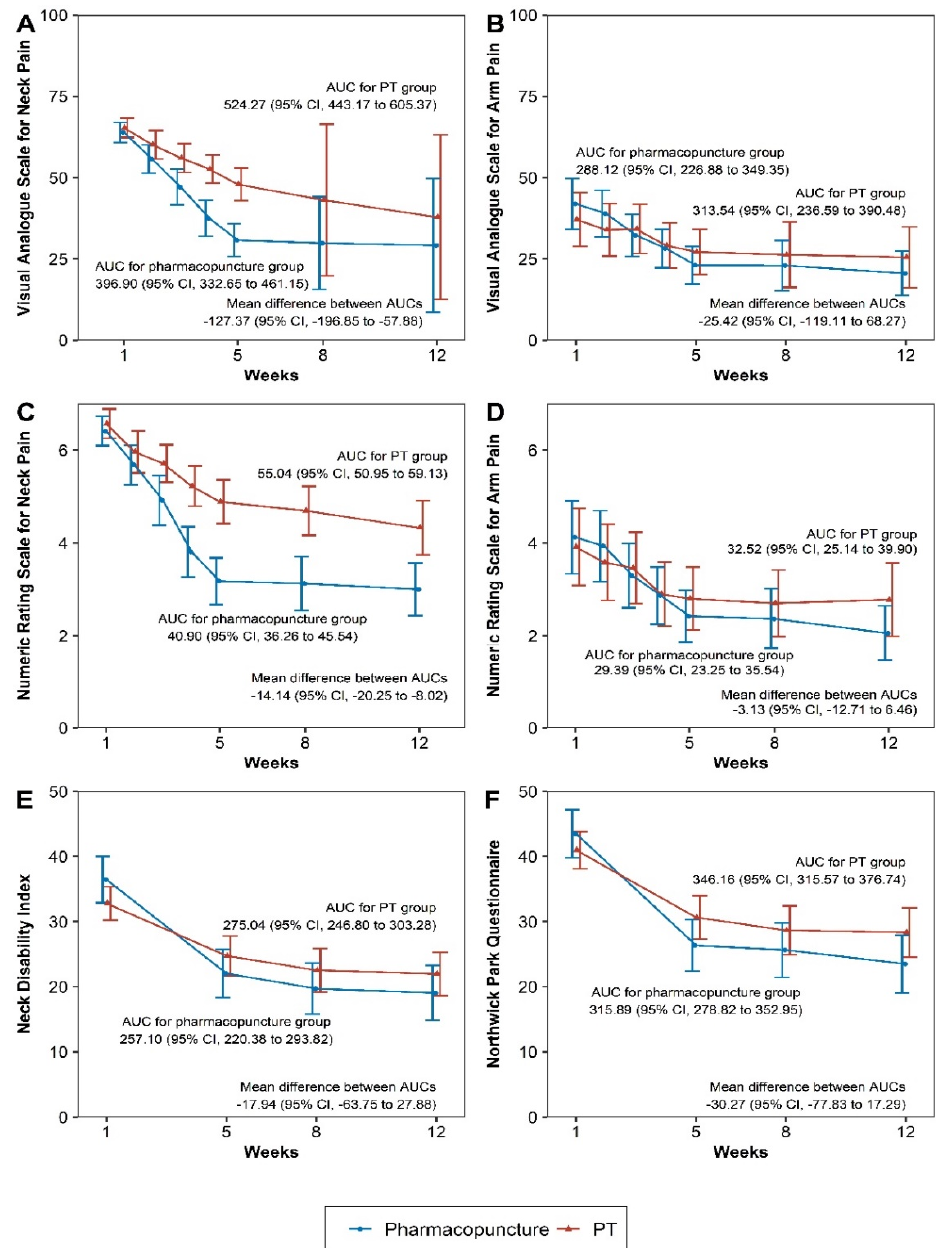
Figure 2. Changes in outcomes over time and areas under the curves. All graphs show the changes in scores for outcomes related to quality of life and physical function during the 12 weeks after randomization. ( A ) VAS score for neck pain; ( B ) VAS score for arm pain; ( C ) NRS score for neck pain; ( D ) NRS score for arm pain; ( E ) NDI score; ( F ) NPQ score. The dots show the mean scores and error bars show the 95% confidence intervals. Missing values were added using multiple imputation. VAS, visual analogue scale; NRS, numeric rating scale; NDI, neck disability index; NPQ, Northwick Park